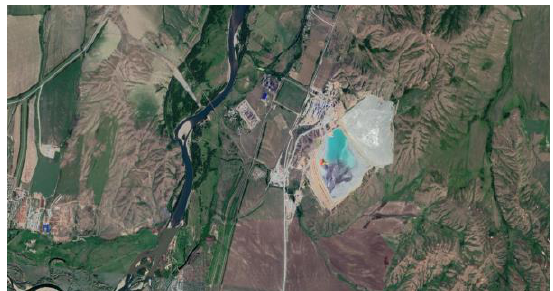
Figure 1 . Position of the tailings dump concentration plant on the map (view from